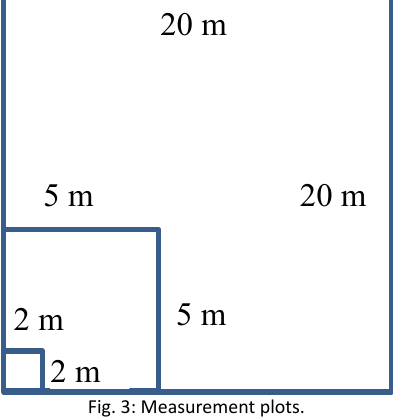
Fig. 3: Measurement plots.